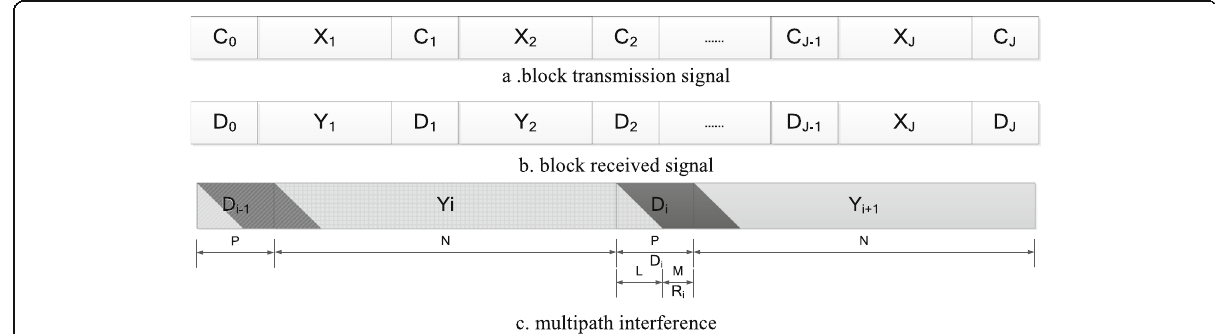
Fig. 1 The SC-FDE frame structure and multipath interference. a Block transmission signal. b Block received signal. c Multipath